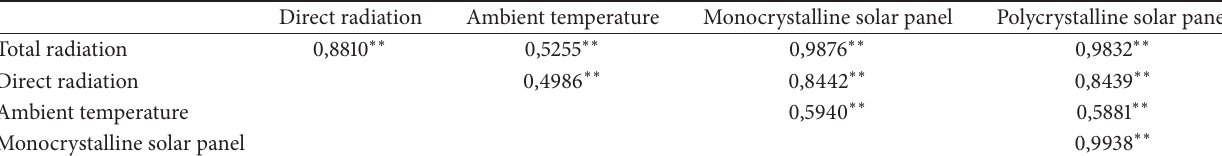
Table 1: Multivariate correlations coefficients.